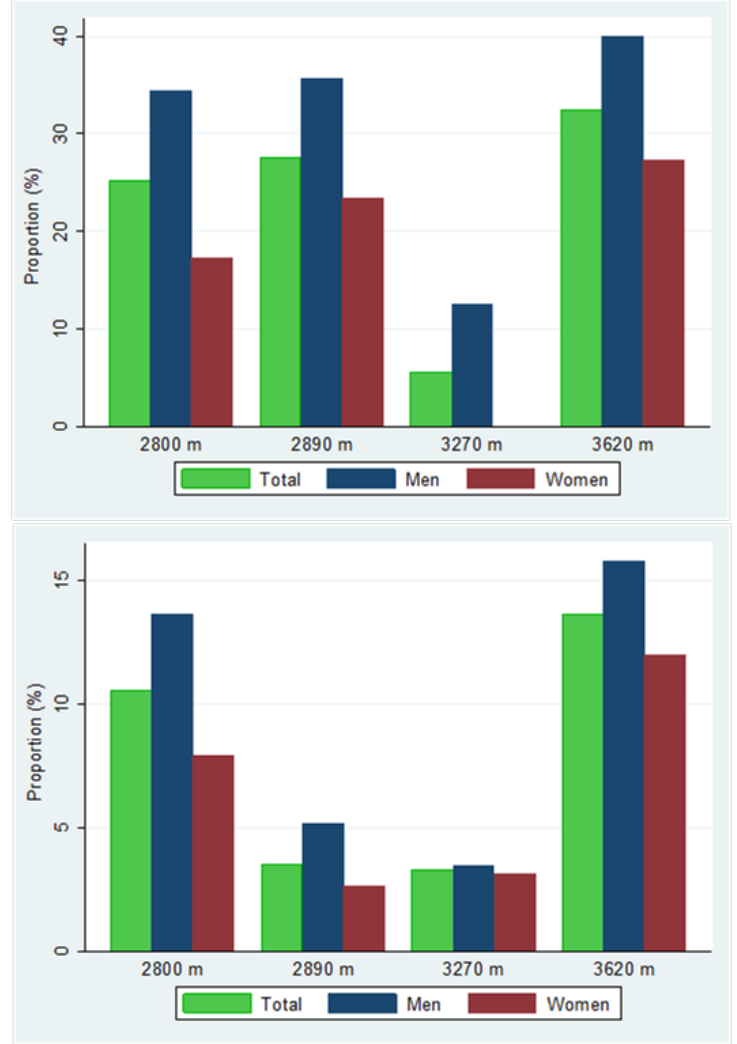
Figure 1. Proportions of high total cholesterol (TC) to high-density lipoprotein-cholesterol (HDL) ratio or on cholesterol treatment (above) and diabetes or on treatment (below) by sex at each altitude level.